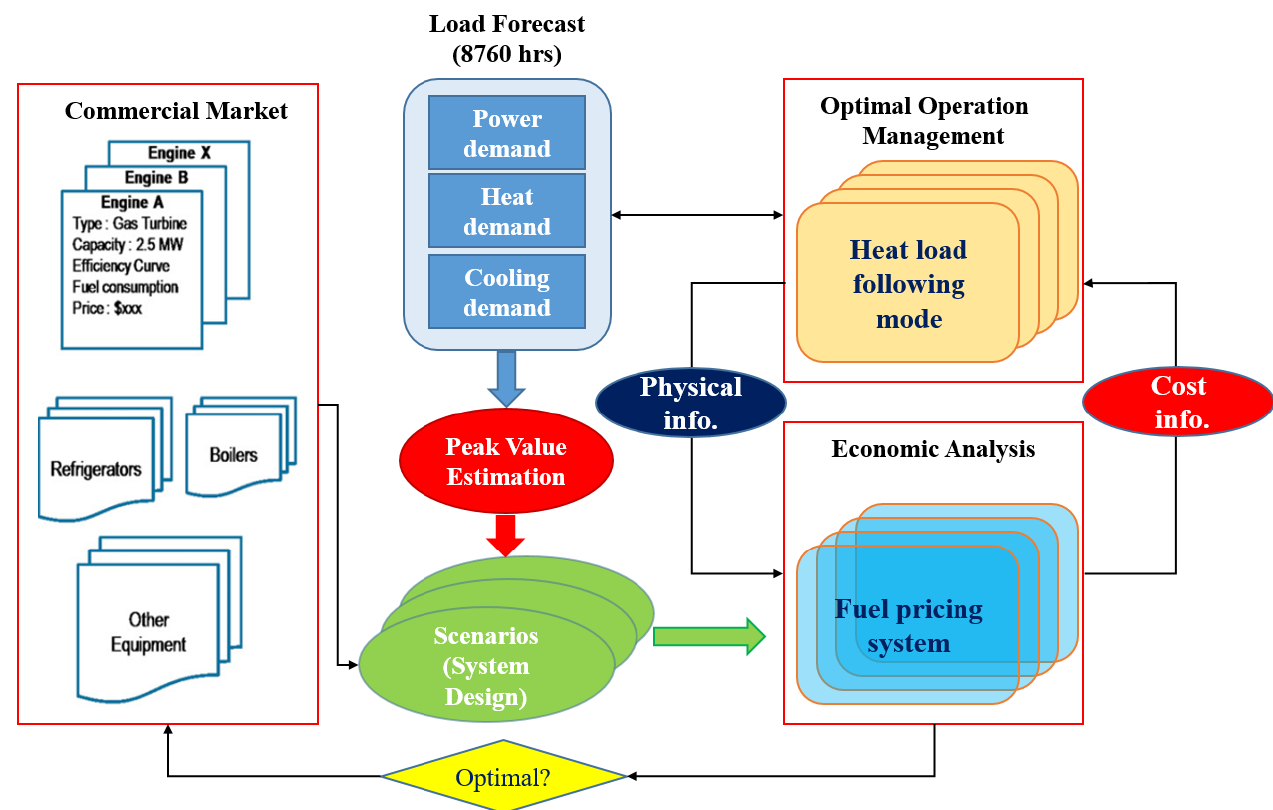
Figure 3. Simplified flowchart for the simulation procedure.